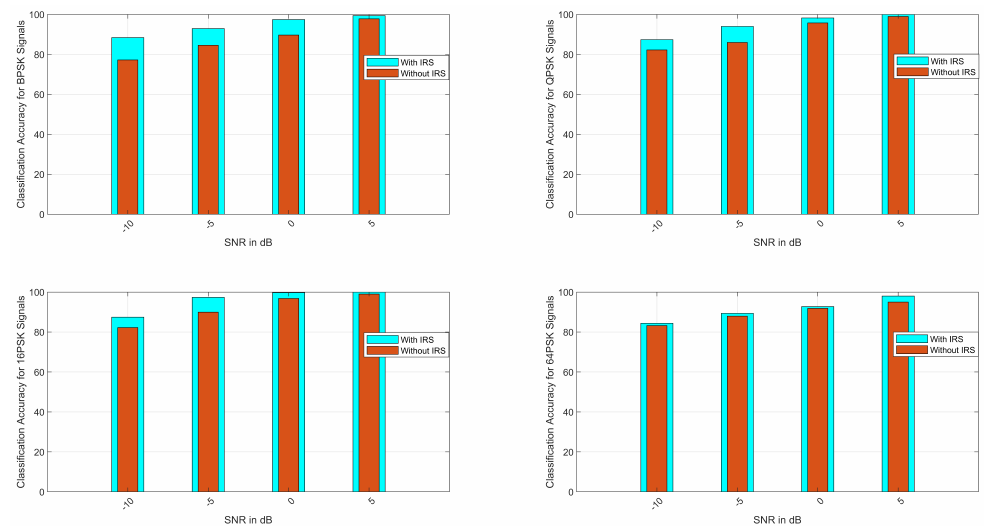
Figure 2. Average classification accuracy for M-PSK signals (BPSK, QPSK, 16-PSK, and 64-PSK).